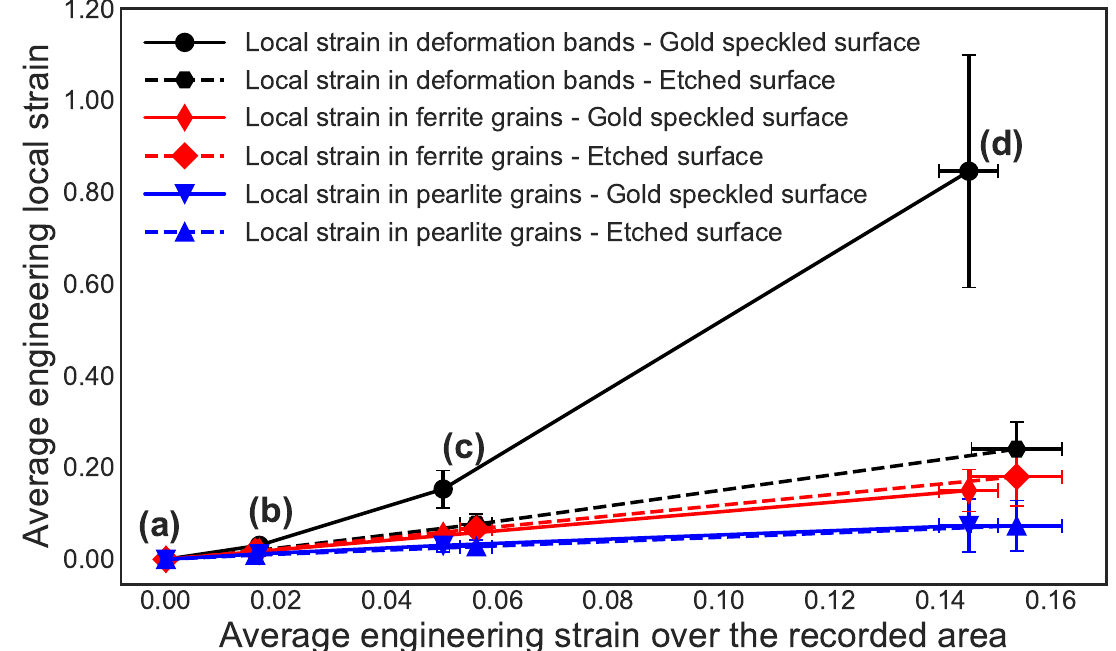
Figure 18. The local strain evolution in Figures 9 and 14 plotted together until